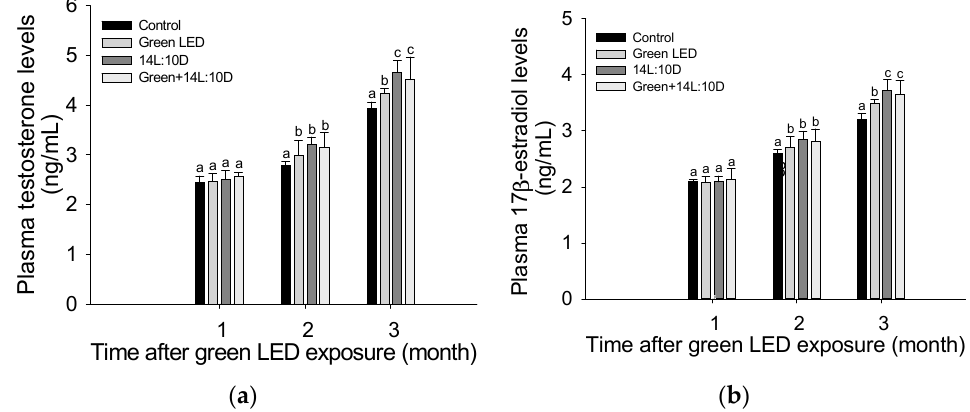
light wavelength.